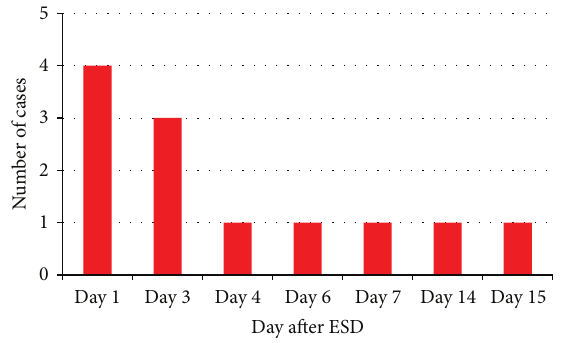
Figure 5: Periods of occurrence of postoperative